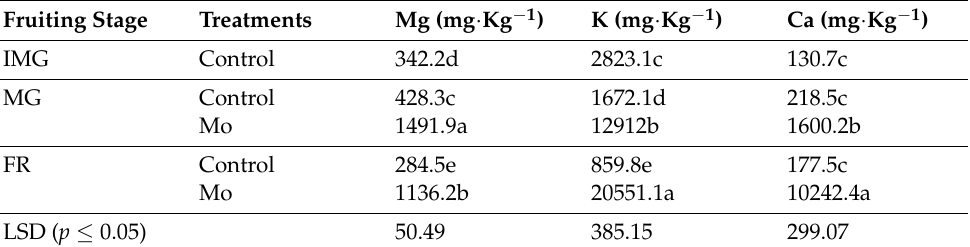
Table 2. Effect of foliar application of molybdenum on macronutrient concentrations in leaves of